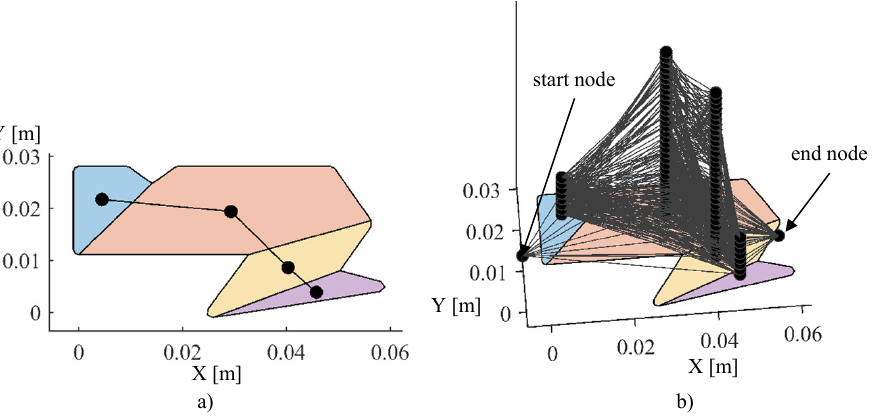
Figure 14. ( a ) Coverage graph with 4 nodes connected by 3 edges and ( b ) weighted infill graph of the example slice with 82 nodes and 544 edges.